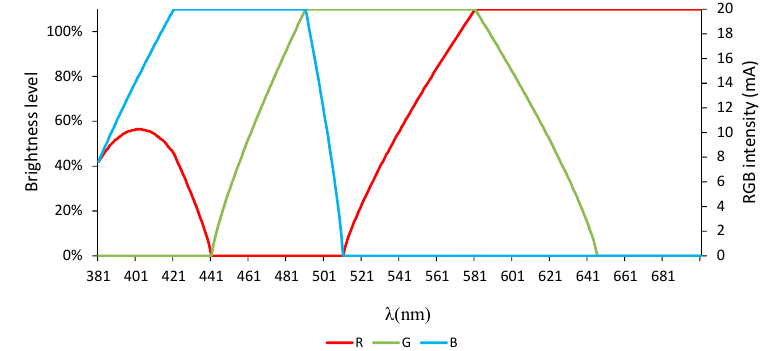
Figure 14. Heuristic RGB values for visible wavelengths by color rendering.